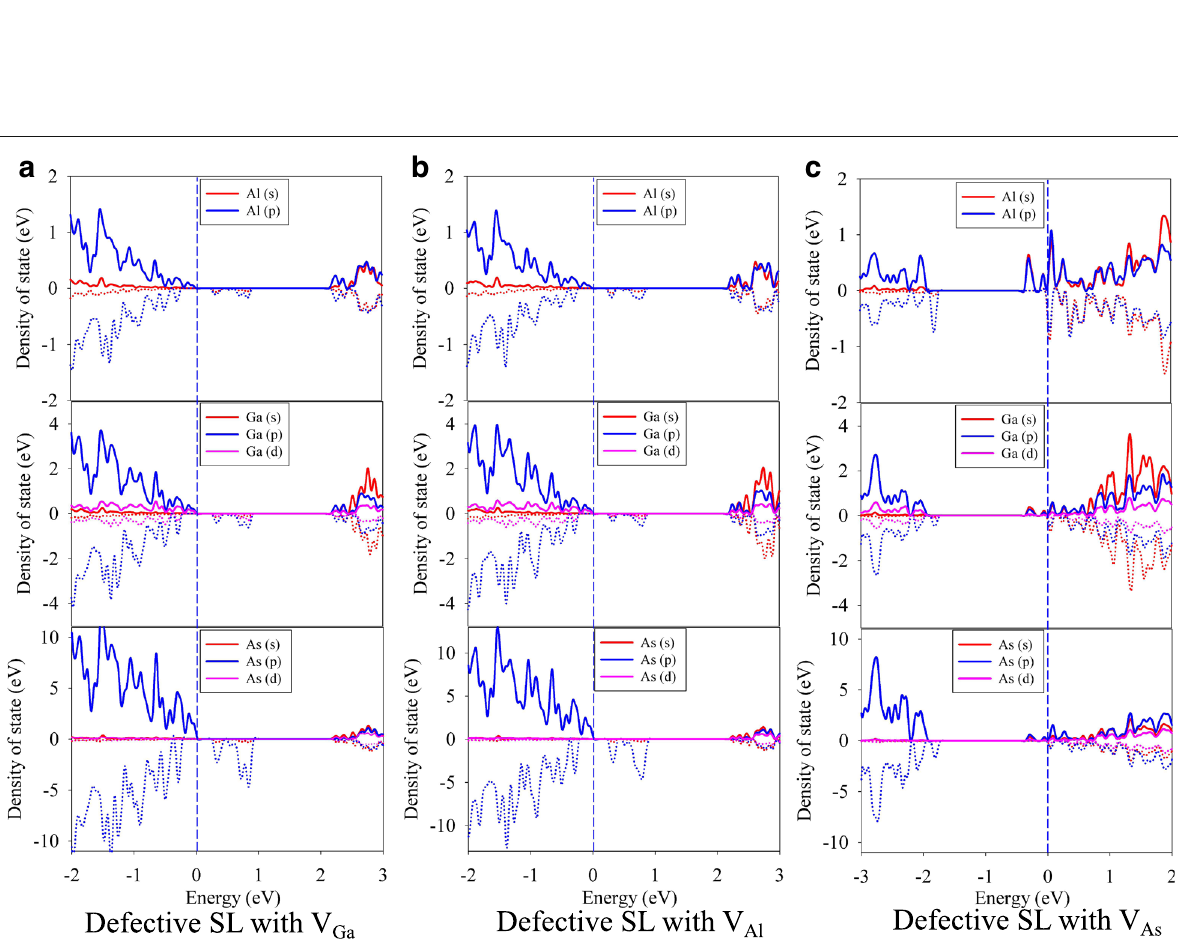
Fig. 8 The partial density of state of defective GaAs/AlAs superlattice with a V Ga , b V Al and c V As vacancy defects. V X (X = Ga, Al, or As) X